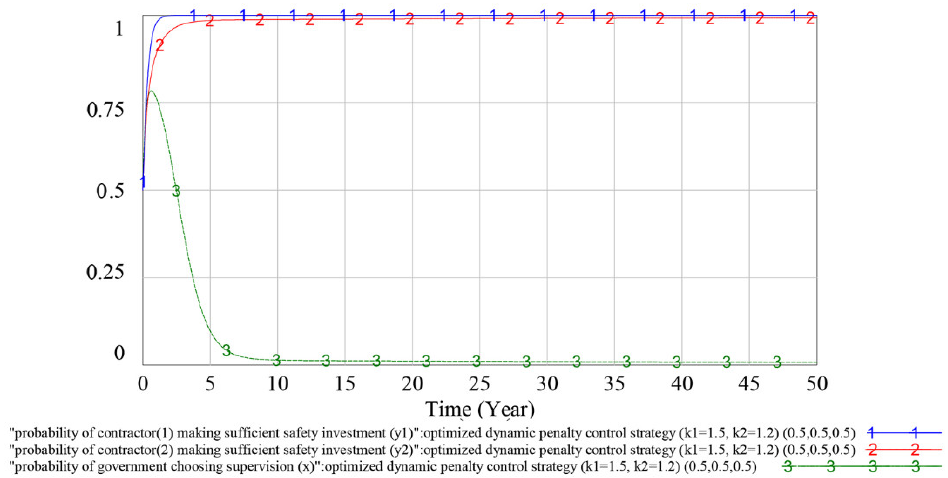
Figure 14. Simulation results under optimized dynamic penalty control strategy (initial value ( y 1 = y 2 = x = 0.5)).